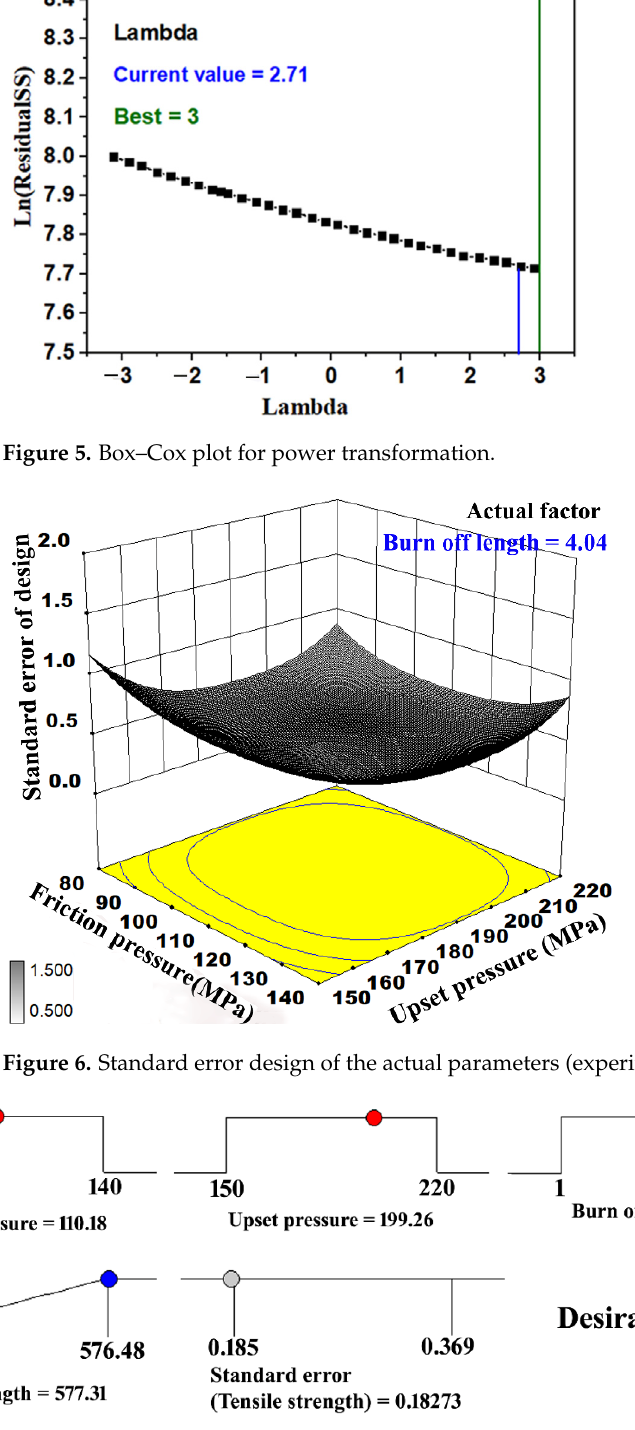
Figure 7. Ramp function graph of desirability optimization.